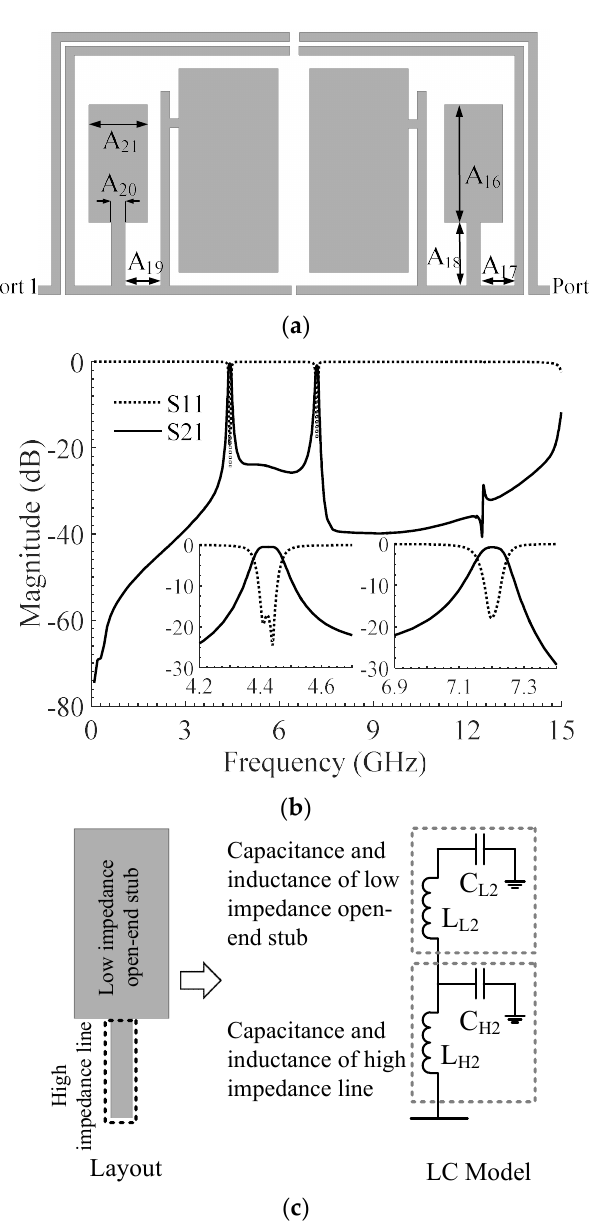
Figure 6. Completed dual-band bandpass filter (BPF): ( a ) Layout, A 16 = 2.6, A 17 = 0.8, A 18 = 1.4, A 19 = 0.8, A 20 = 0.3, A 21 = 1.3 (all in mm), ( b ) EM simulation, ( c ) LC model of stepped-impedance resonator.